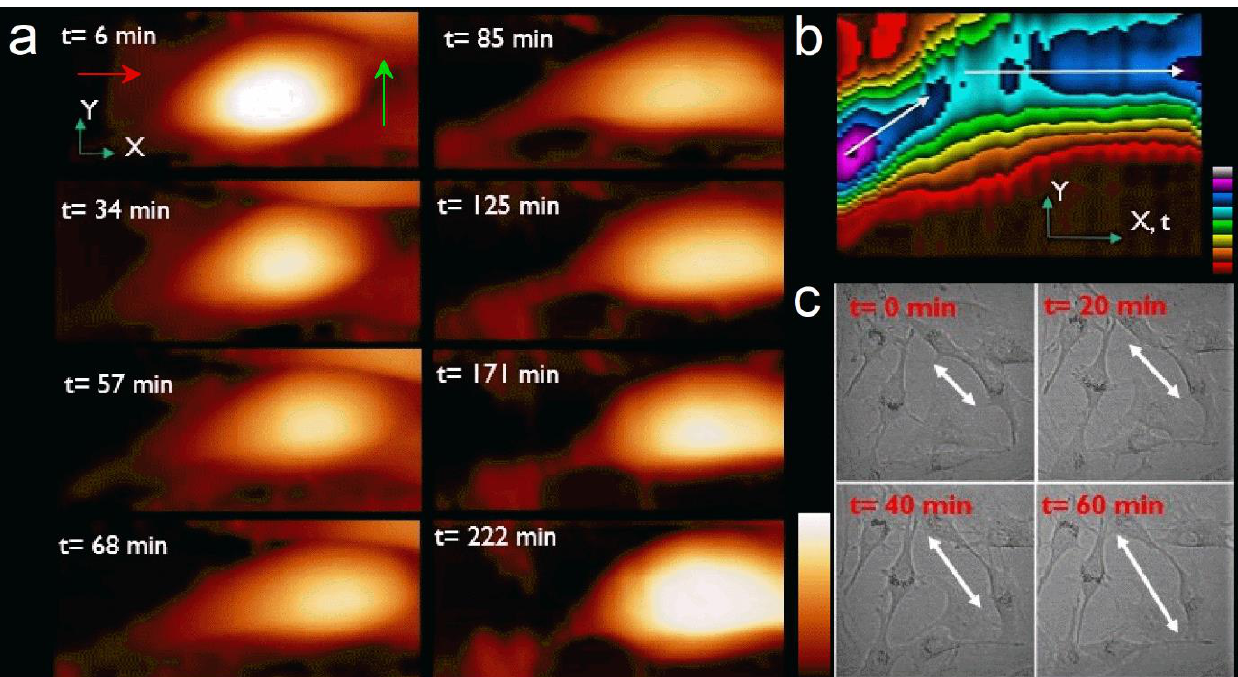
Figure 1. ( a ) Series of topographic images (70 µm × 31 µm) recorded in real time for a single CRFK cell during its motion on glass surface for t = 6, 34, 57, 68, 85, 125, 171, and 222 min respectively. Z-scale = 3.5 µm. Some residues (red arrow, t = 6 min) and protuberance (green arrow, t = 6 min) are visible from the start of the experiment. ( b ) Kymograph of the trajectory of the cell with time along the X – Y defined from the borders of the images. The cell starts moving about 45° from X-axis during 90 min. Then it changes direction to follow X-axis during the rest of the experiment (Z-scale, colors, 4 µm). ( c ) Optical microscope images (200 µm × 200 µm) of the motion of CRFK cell onto glass substrates show the dynamics and morphologies of the cells anchored to each other during movement (white arrow).